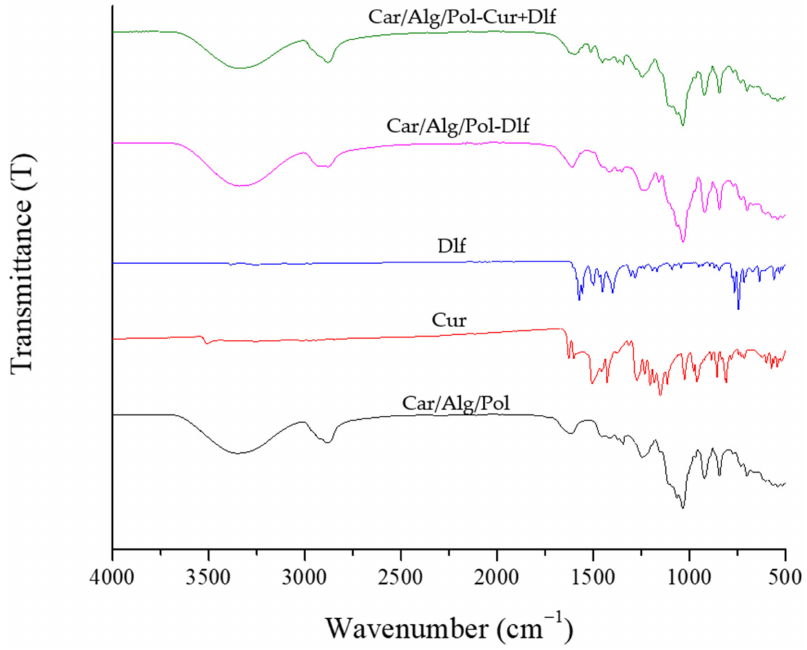
Figure 1. FTIR spectra of curcumin, diclofenac, and the Car/Alg/Pol, Car/Alg/Pol Dlf and Car/Alg/Pol-Cur+Dlf